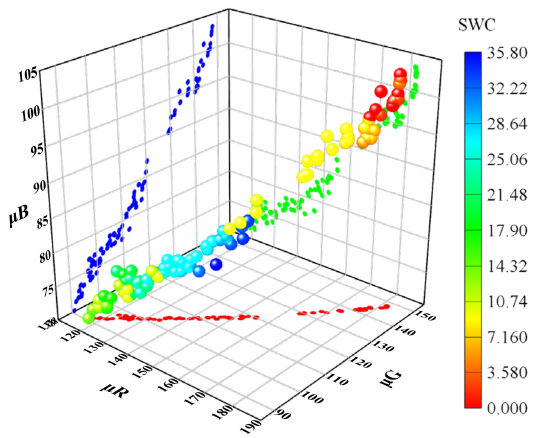
Figure 5. Relationship between characteristic parameters from the RGB color space and